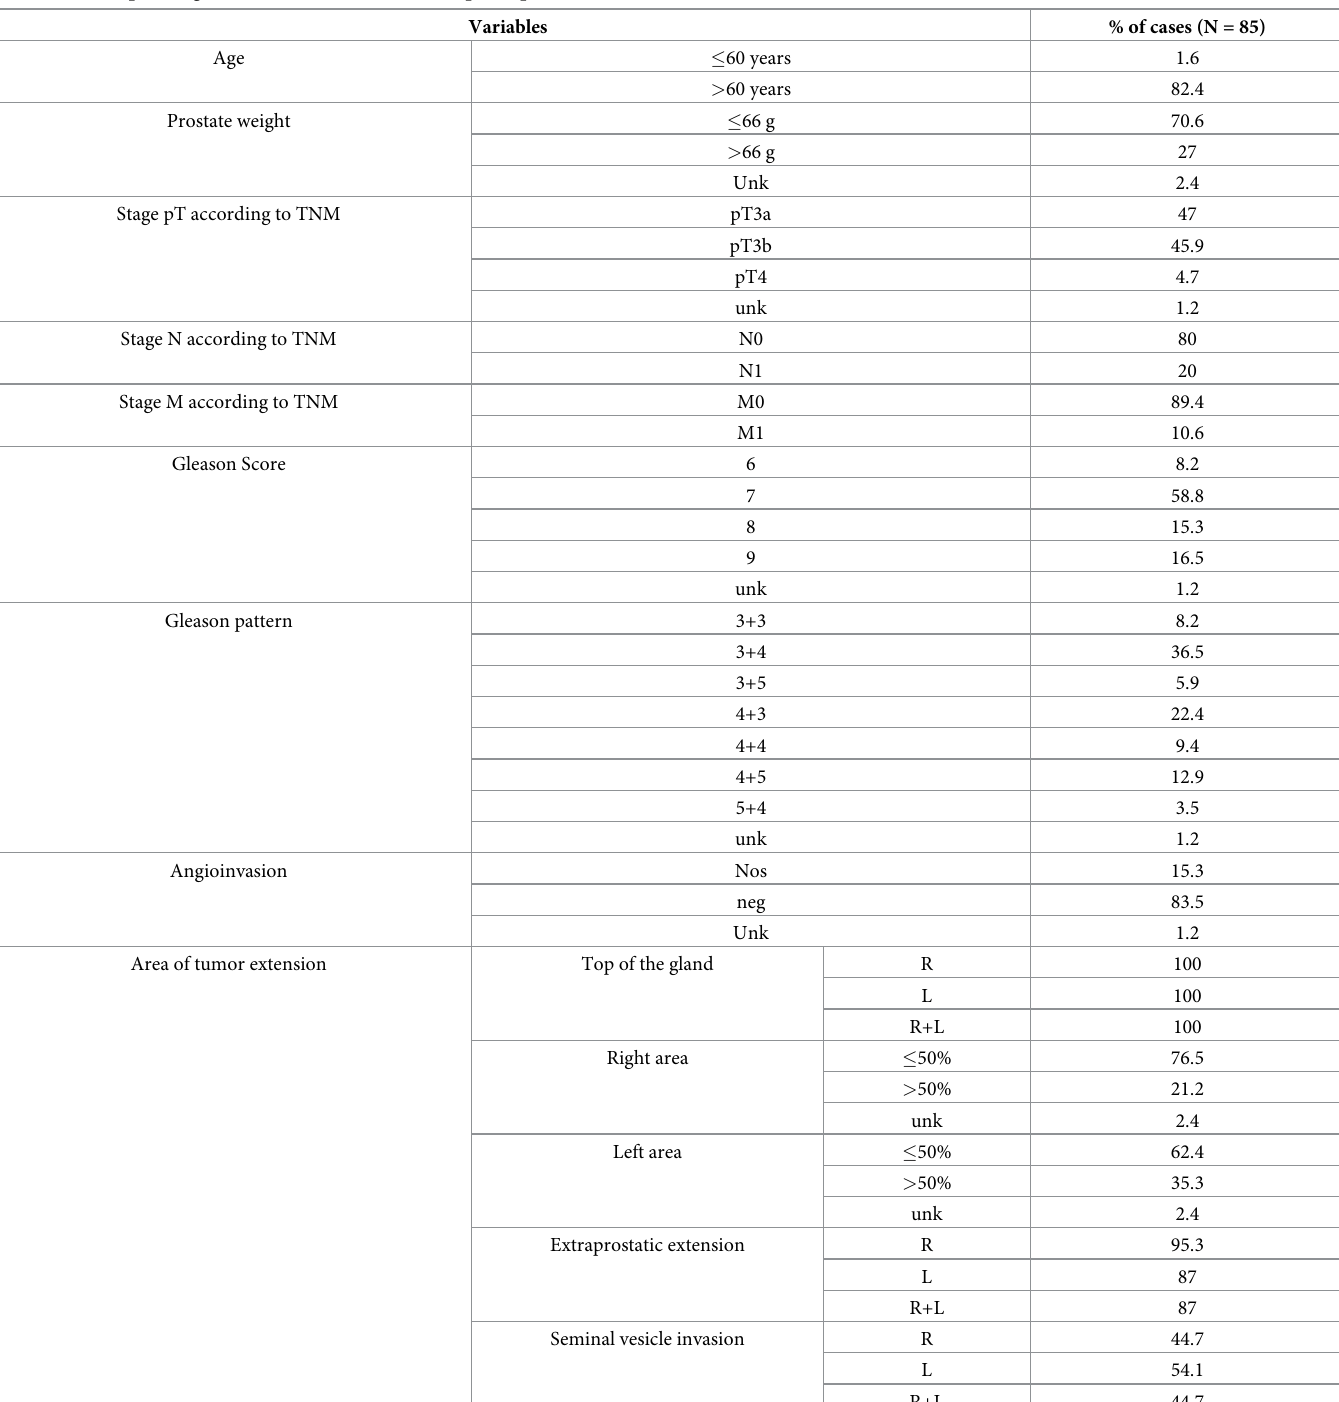
Table 1. Clinicopathological characteristics of identified